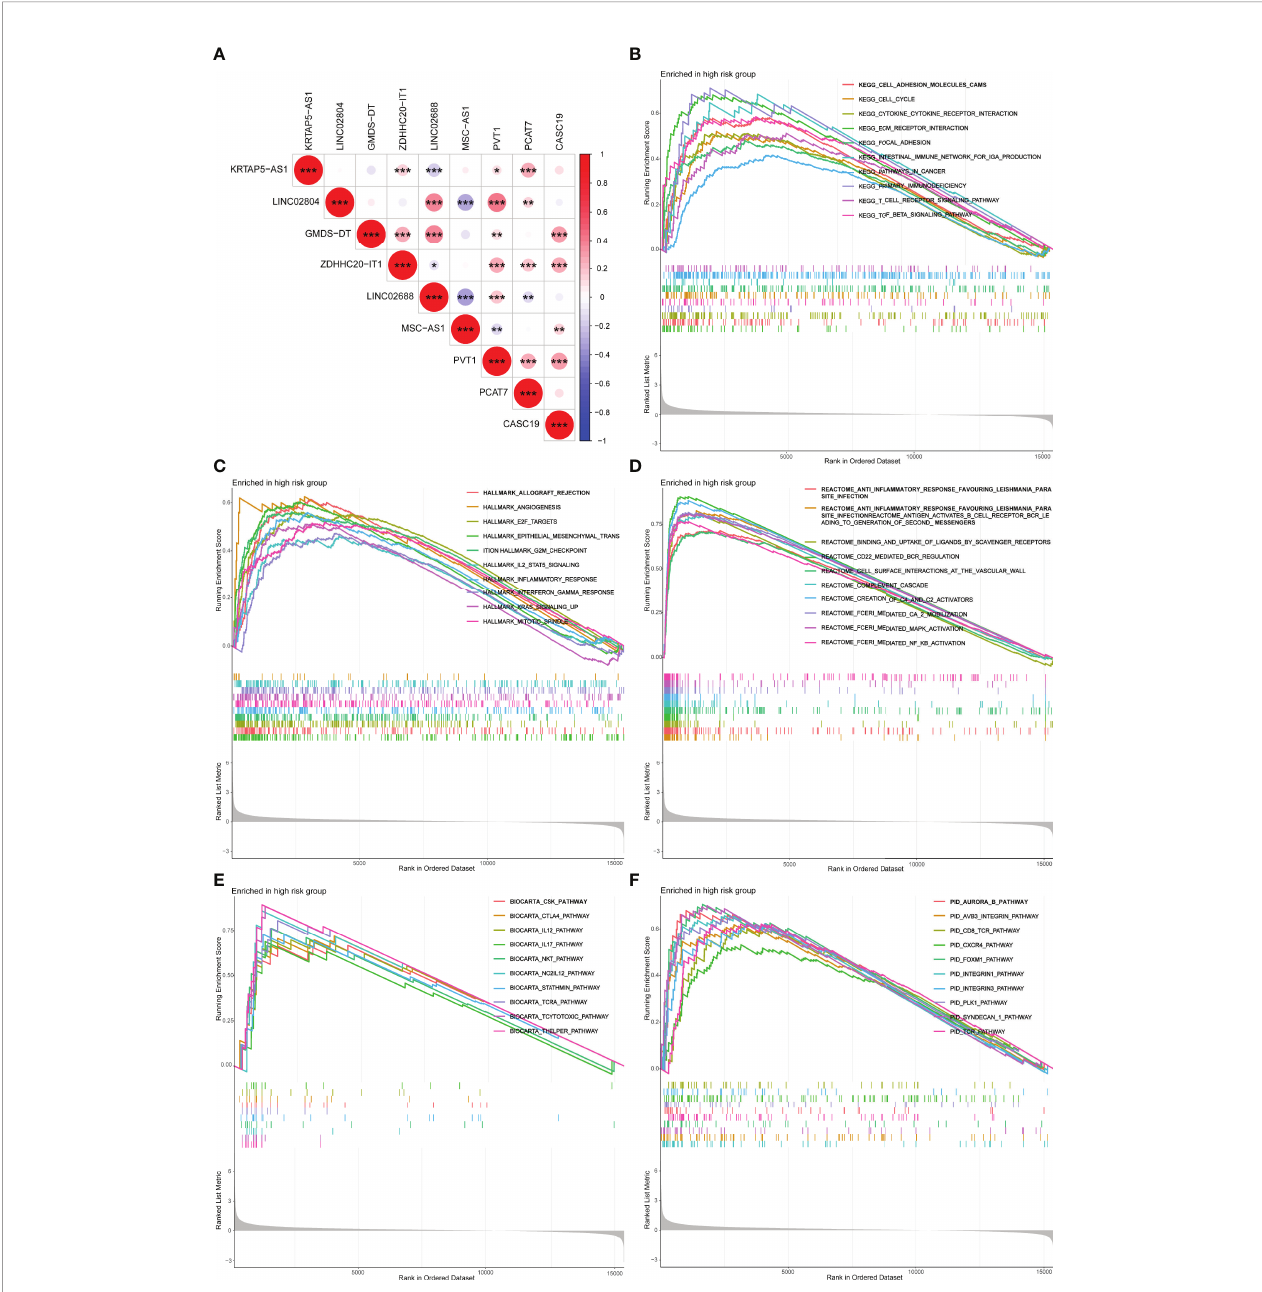
FIGURE 8 | Co-expression network and functional enrichment analysis of m7Gscore-de fi ned groups. (A) Co-expressed correlation among the hub m7G-related lncRNAs in PCa. (B – F) GSEA results of KEGG (B) , Hallmark (C) , Reactome (D) , BioCarta (E) , and PID (F) . lncRNAs, long non-coding RNAs; PCa, prostate cancer; GSEA, gene set enrichment analysis. *p < 0.05; **p < 0.01; ***p <